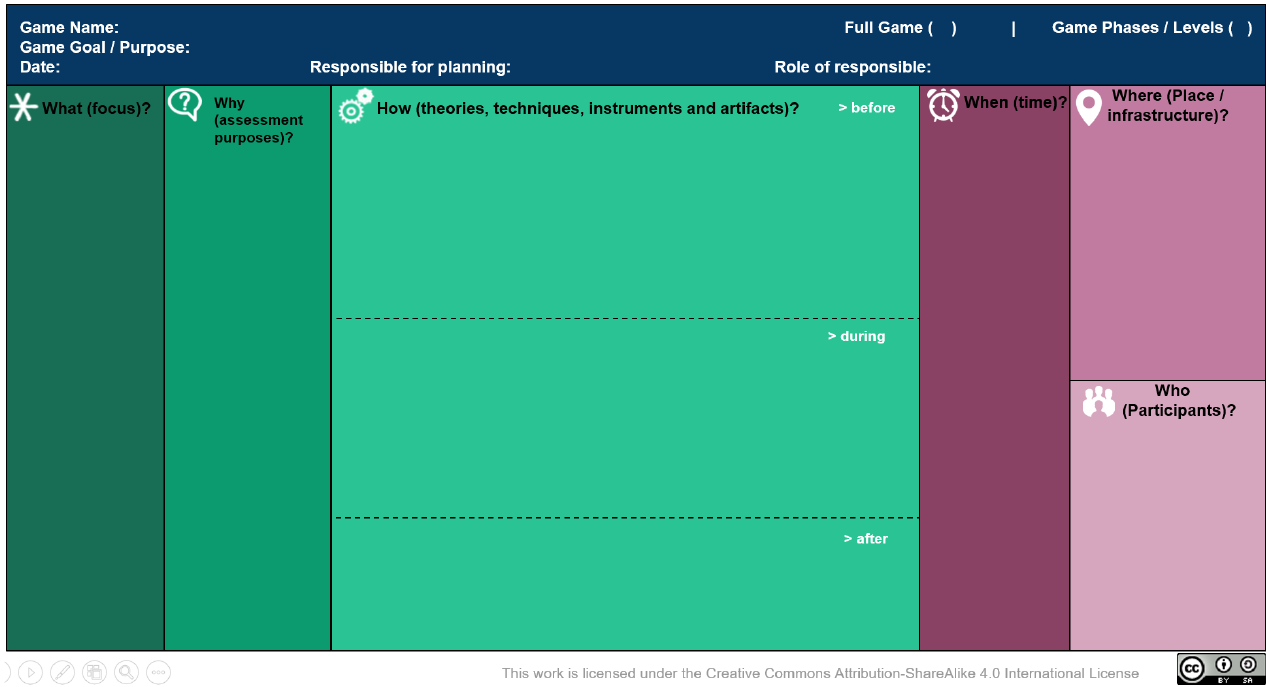
Figure 3. Canvas model for the planning of assessment in